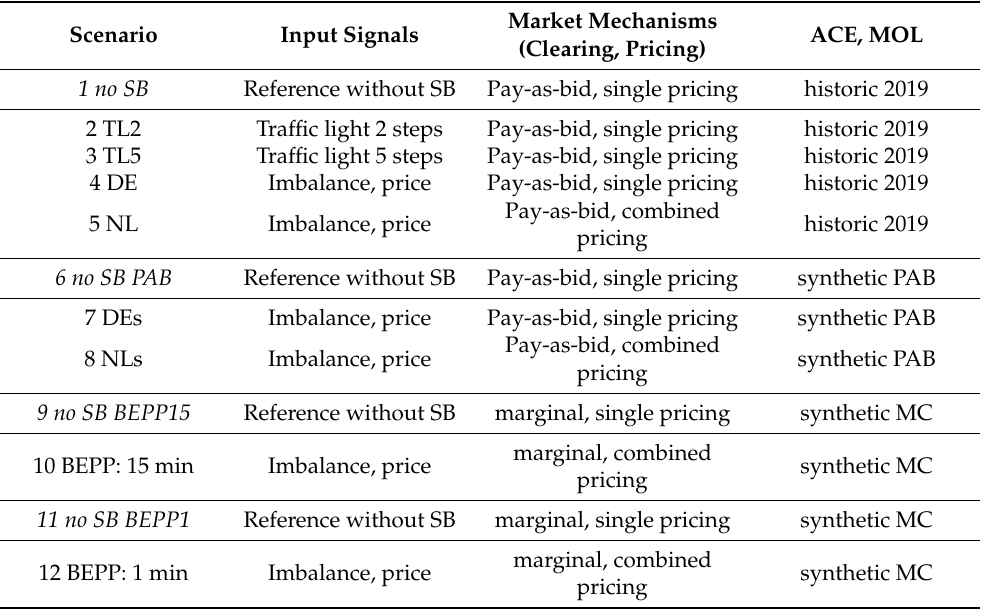
Table 2. Overview of investigated scenarios.